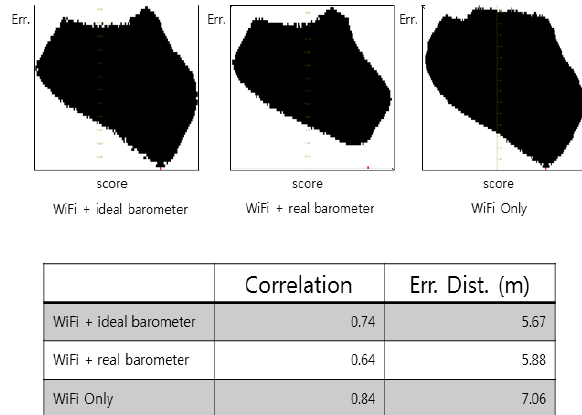
Figure 4. 3D positioning error distance with considering Wi-Fi and Ideal/Real